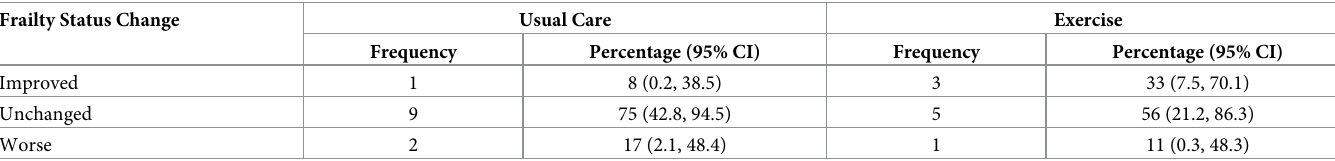
Table 4. Frailty status change for usual care and exercise groups. Frailty Status